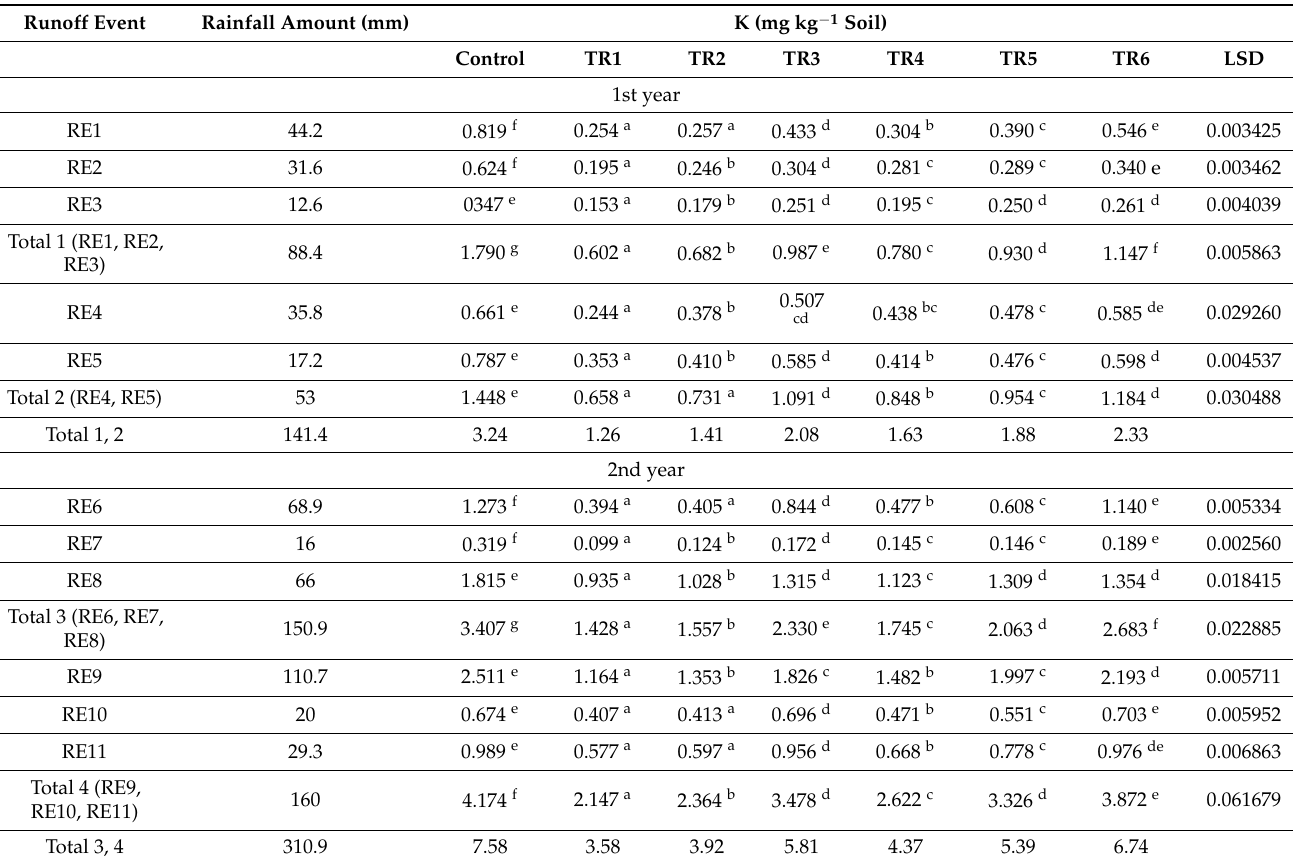
Table 7. Mean values of potassium loss (mg kg − 1 soil) in the seven treatments of the two cultiva- tion years.